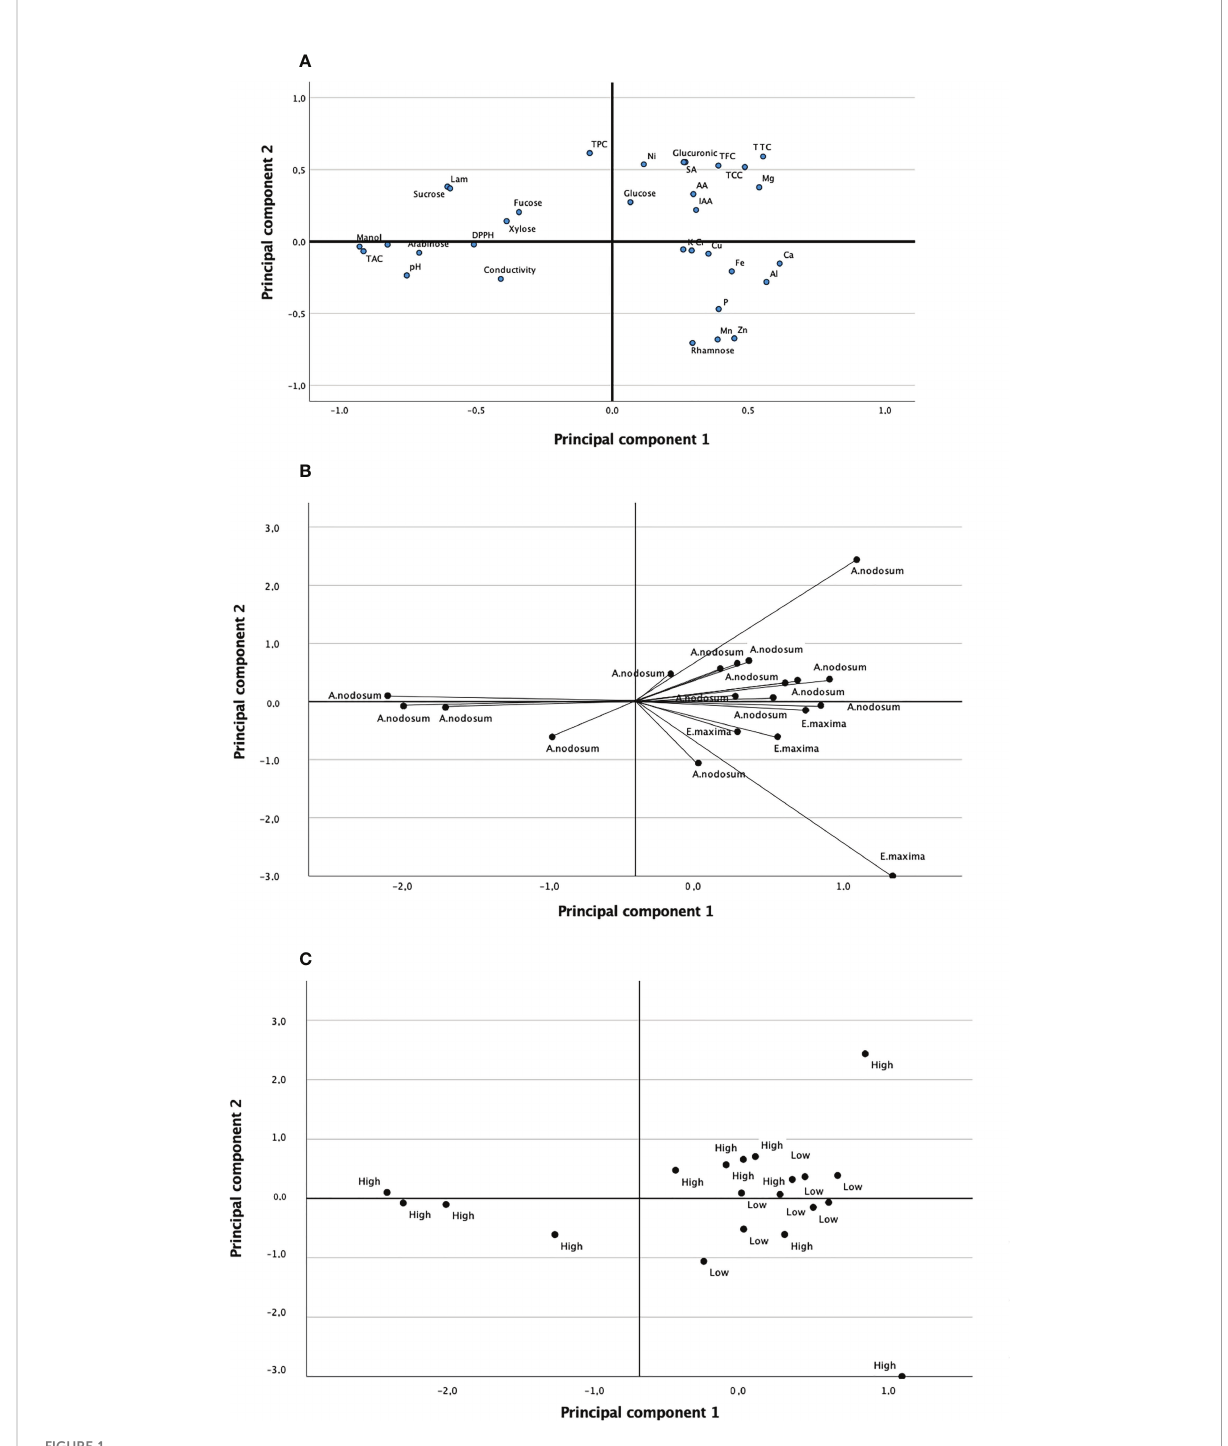
FIGURE 1 (A) Principal components plot in rotated space of variances of seaweed extracts based on chemical composition; (B) PCA based on algae species ( AN and EM ); (C) PCA based on algae percentage in products studied (low and